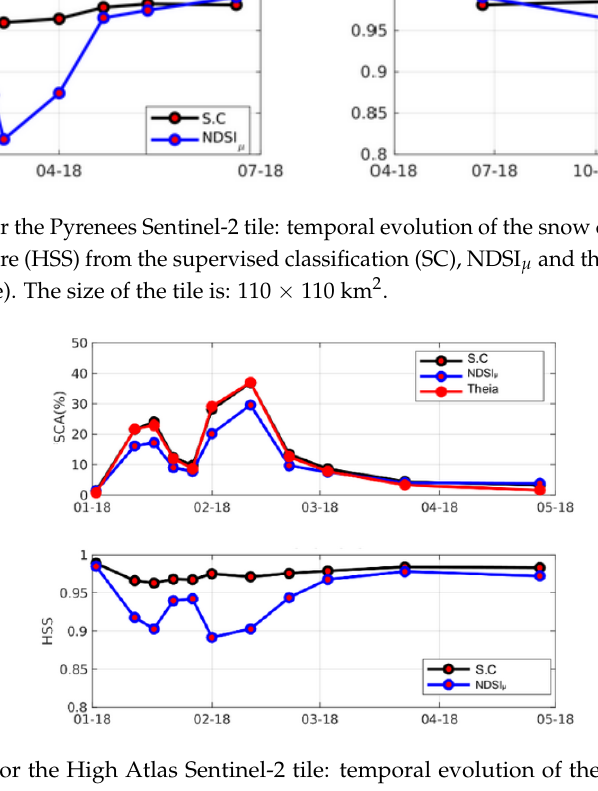
Figure 4. Results for the High Atlas Sentinel-2 tile: temporal evolution of the snow cover fraction (SCA%) and HSS from the supervised classification (SC), NDSI µ and the Theia snow product (used as a reference). The size of the tile is: 110 × 110 km 2